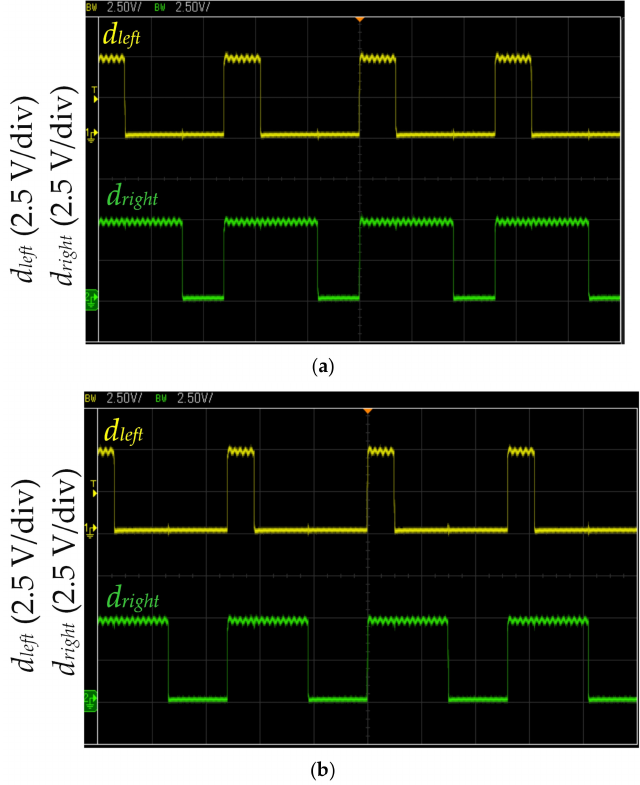
Figure 13. MCU output d left and d right waveforms during left turning: ( a ) with proposed LCOT control strategy and ( b ) with fixed duty cycle method. (The horizontal axis: 2 µ